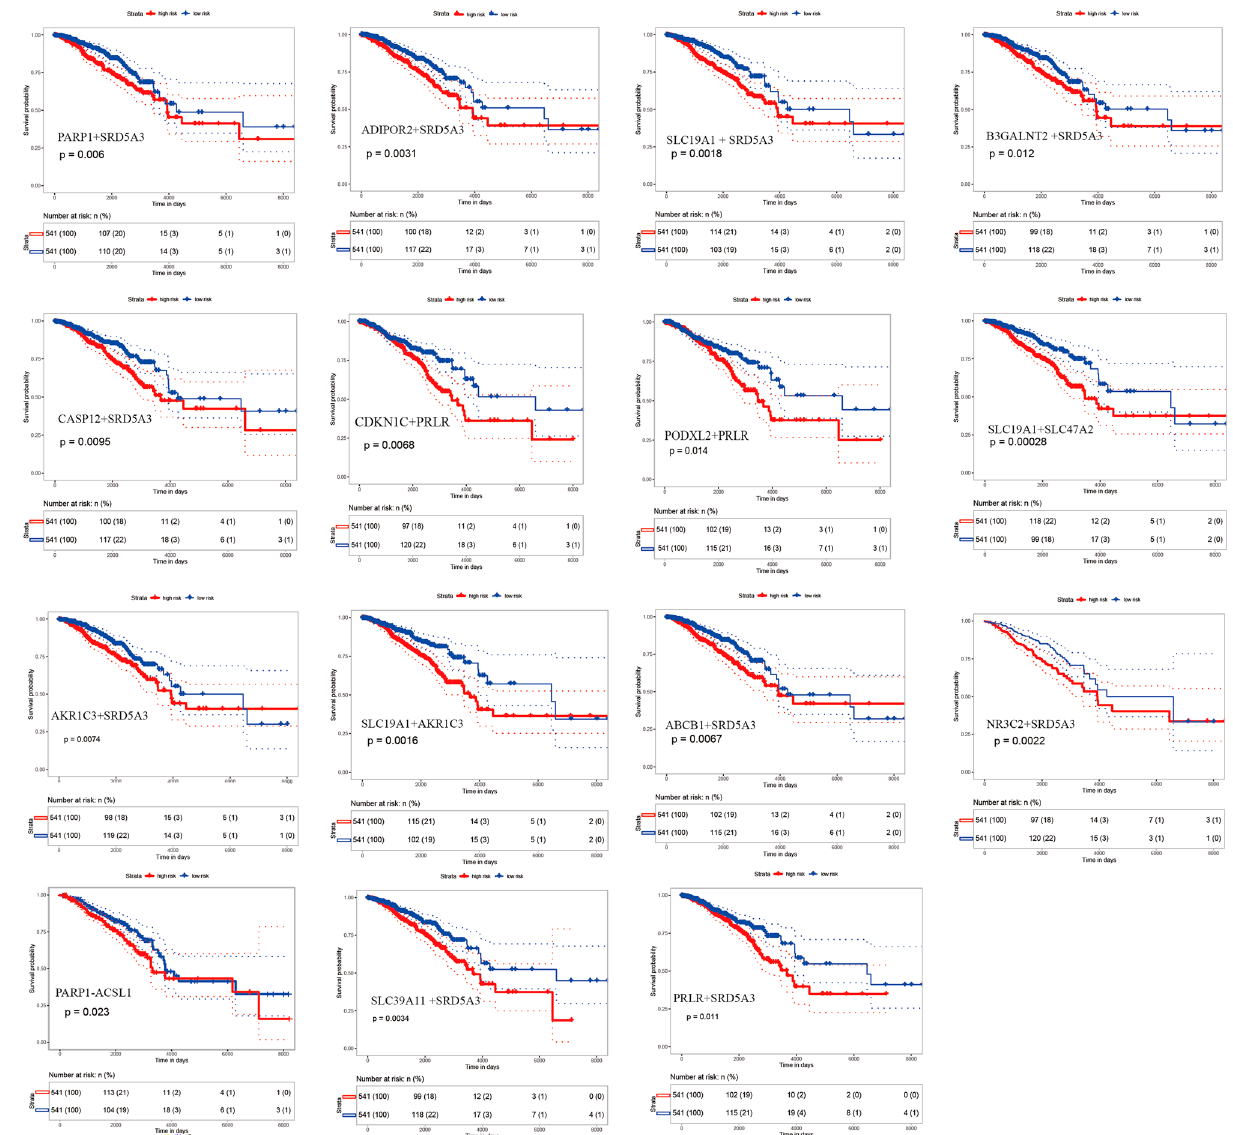
Figure 4. Survival analysis of genetic alteration-driven gene pairs in a TCGA cohort. Comparison of overall survival among patients with high (red) or low (blue) risk scores for each genetic alteration-driven gene pair by Kaplan–Meier analysis (with log-rank values) in a cohort of breast cancer patients from